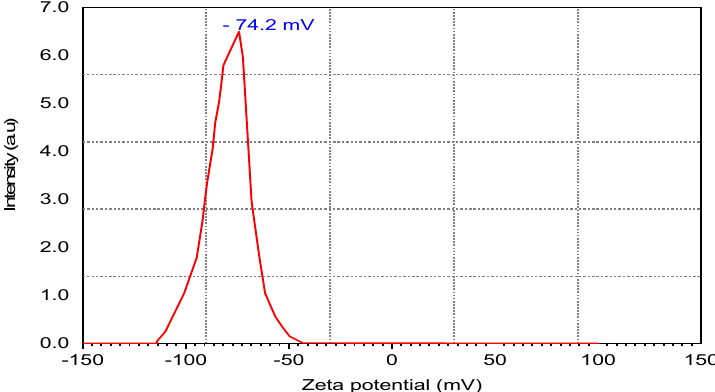
Figure 10. Zeta potential data of bio–fabricated Ag NPs using GB leaf extract.